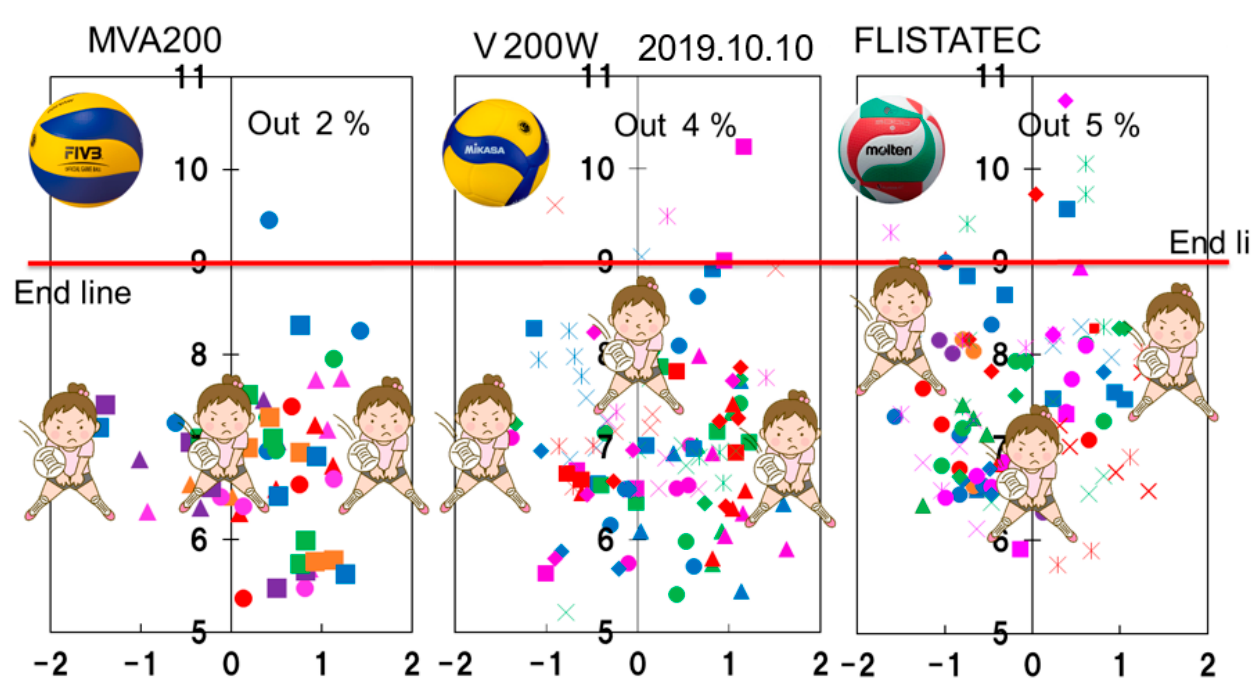
Figure 11. Ideal receiver position and standard deviation.